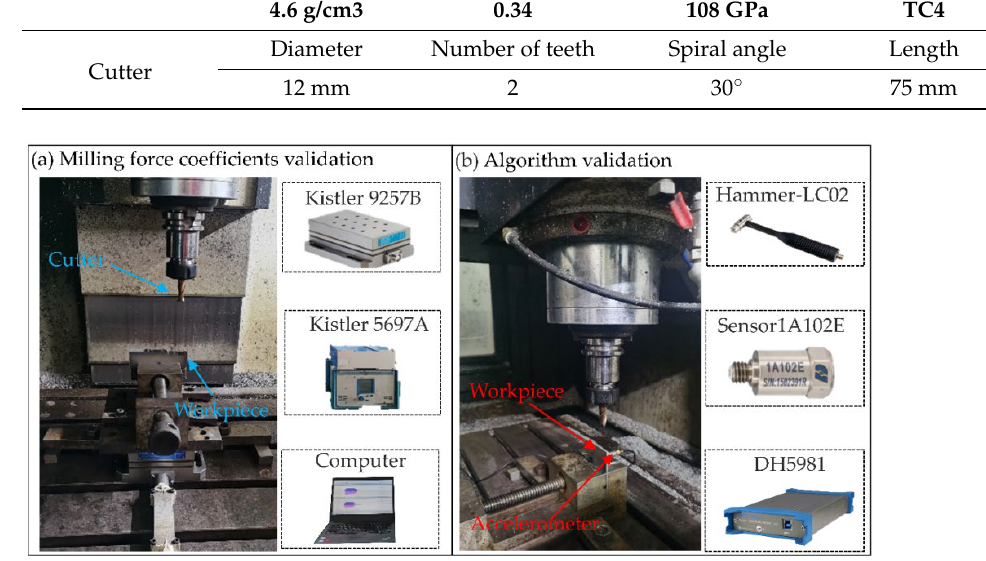
Figure 8. Machining and modal test. Table 3. Workpiece and tool